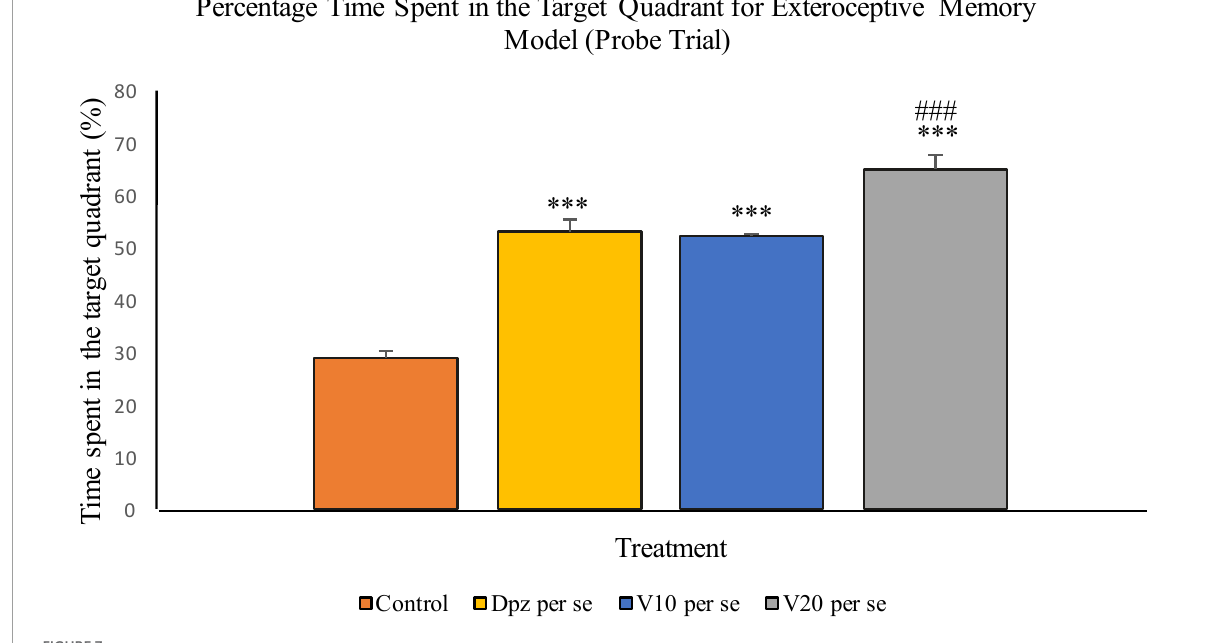
FIGURE7 Effect of vanillin and other treatments on percentage time spent in the target quadrant (probe trial). Data are expressed as mean ± SEM. “***” denotes P < 0.001 with respect to the control group within the probe trial. “###” denotes P < 0.001 with respect to the standard treatment group within the probe